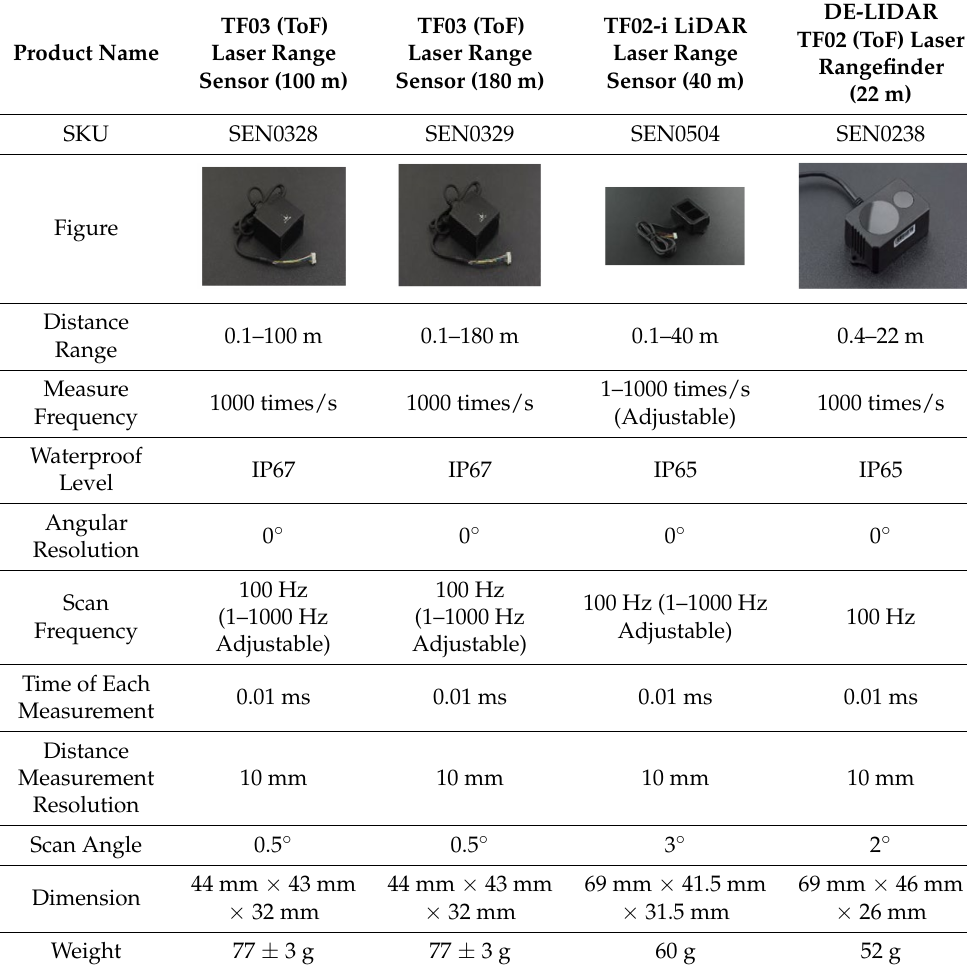
Table 1. Examples of unidirectional laser radar sensors on the market useful for the monitoring of bridges.